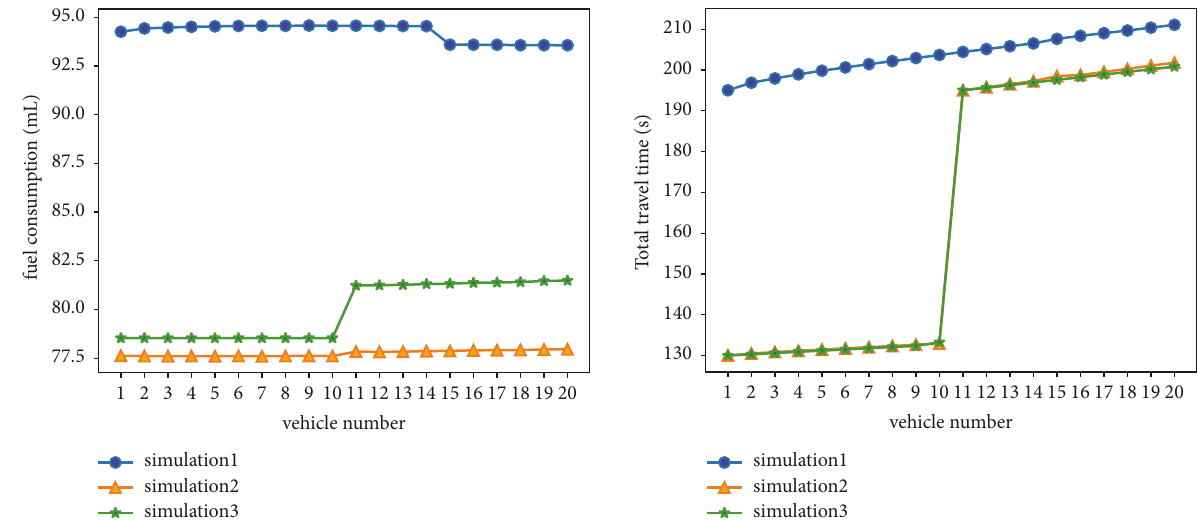
Figure 10: The total fuel consumption and the total travel time of each